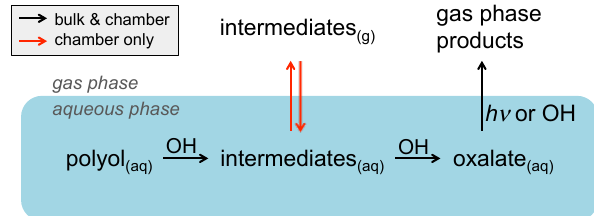
Figure 6. Simplified mechanism to explain observed differences be- tween oxidation in the bulk and in submicron particles. The polyol reacts to form intermediates with lower H ∗ (higher volatility over water), which remain fully in the aqueous phase during bulk exper- iments, but partition to the gas phase (red arrows) during chamber experiments. This partitioning, which occurs to a greater extent for smaller polyol precursors, competes with further aqueous oxidation, and has the effect of lowering the product (oxalate) yield. Upon ex- posure to ultraviolet light, the Fe(III) oxalato complex photolyzes, forming small gas-phase